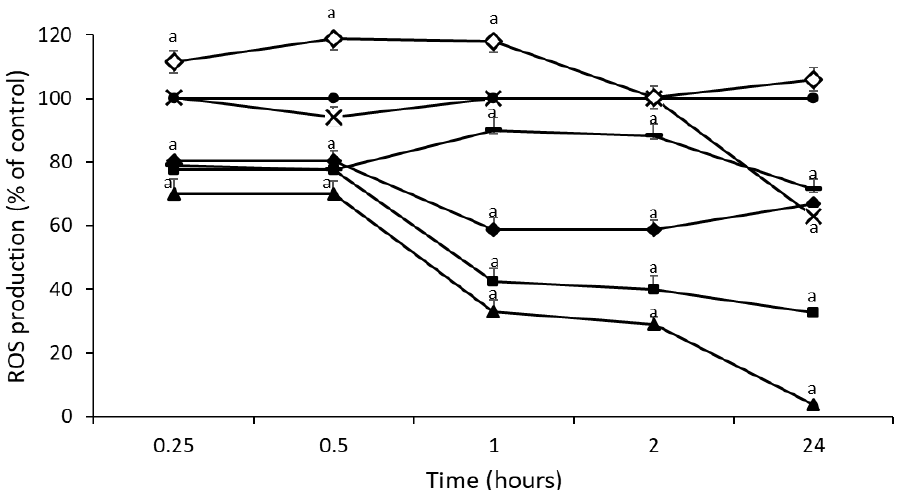
Figure 1. Time course of ROS production in untreated HepG2 cells (●) and treated with NAC ( ■ ), sample 1 (TH) ( ◆ ), sample 6 (CH) ( ▬ ), sample 15 (RJ) (X), sample 16 (PR) ( ▲ ), and sample 17 (AH) ( ◇ ). Significant difference from control a p < 0.05.